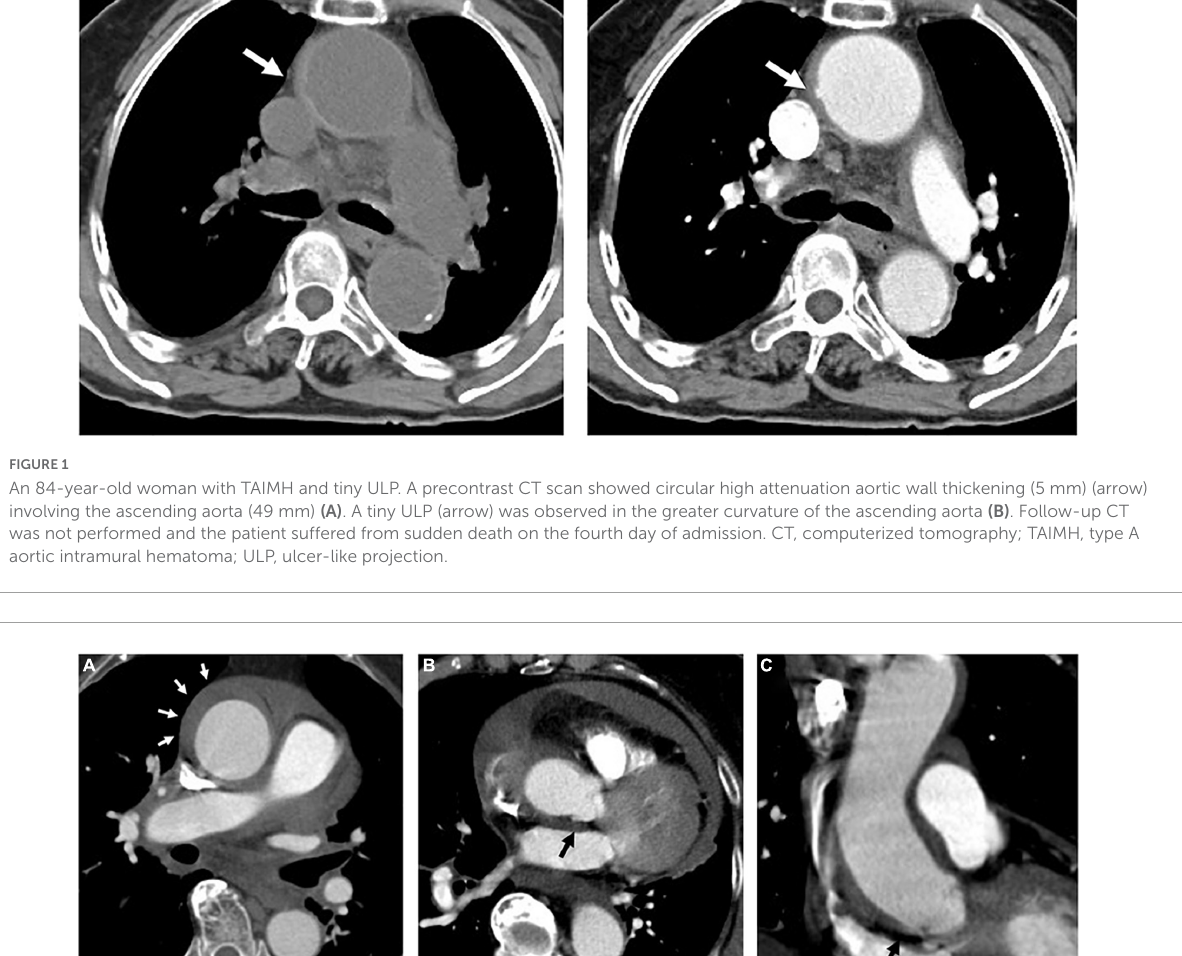
( P = 0.03, P < 0.001, and P = 0.01, respectively); the MAD